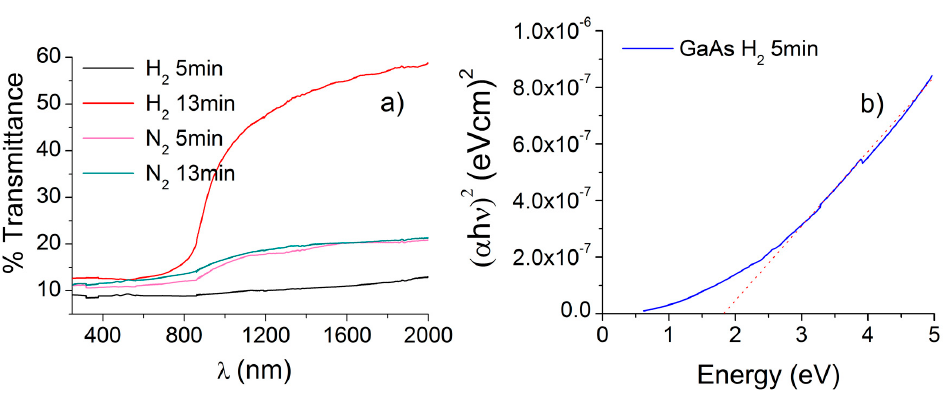
Figure 3. ( a ) Transmittance spectra of GaAs layers grown by CSVT as a function of the gaseous atmosphere. ( b ) Determination of the bandgap using the Tauc relationship. The plot obtained from the sample grown in a hydrogen atmosphere for 5 min is shown as an example. Table 1. Thickness obtained for the GaAs films by a profilometer and the calculation of E g by Tauc Plot.